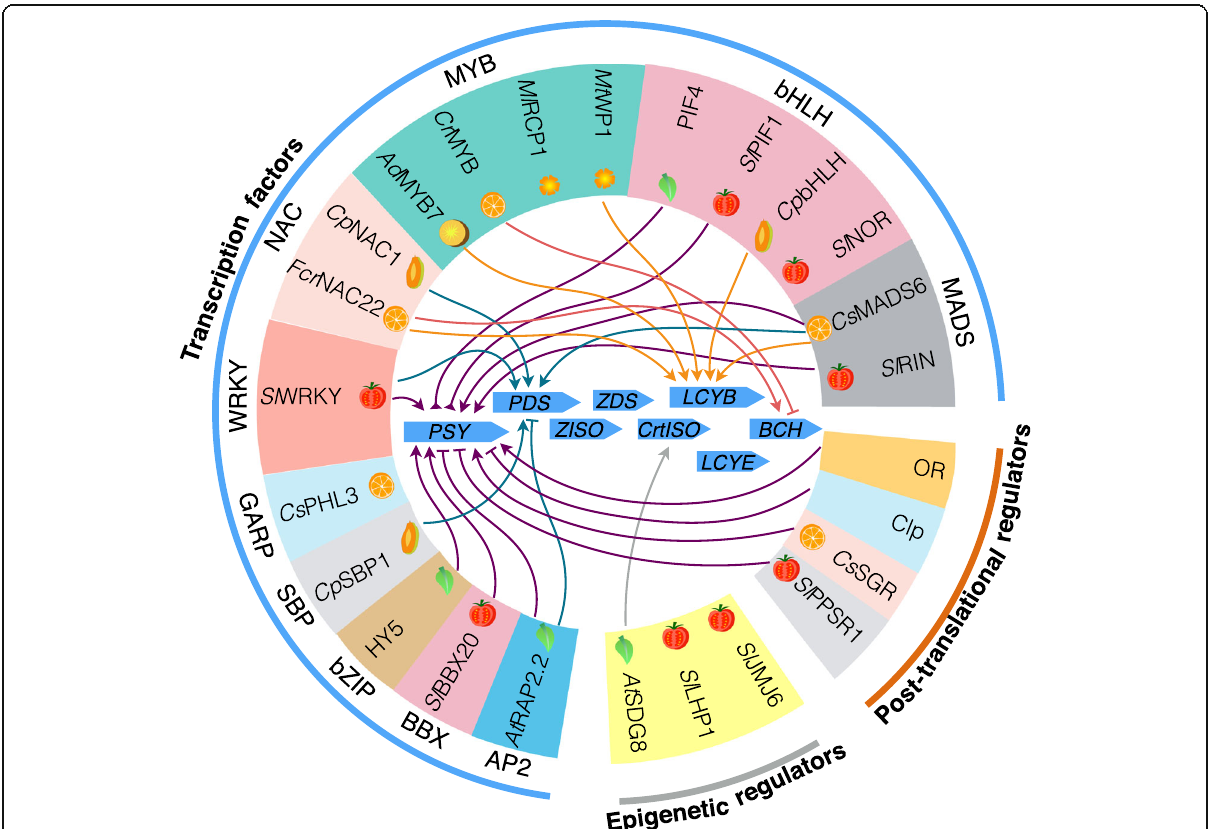
Fig. 3 Summary of some known transcription factors, post-translational regulators, and epigenetic regulators that regulate the expression of carotenogenic pathway genes or PSY protein. Their direct actions on pathway genes or PSY protein in different organs such as leaf, carotenoid- rich fruit, and flower are indicated. Those transcription factors are clustered by the family of transcription factors. MYB, Myeloblastosis family of transcription factors; RCP1, REDUCED CAROTENOID PIGMENTATION1; WP1, WHITE PETAL1; NAC, NAM, ATAF, and CUC transcription factors; WRKY, WRKYGQK motif-containing transcription factors; PHL3, PHOSPHATE STARVATION RESPONSE FACTOR LIKE3; SBP1, SQUAMOSA PROMOTER BINDING PROTEIN1; HY5, ELONGATED HYPOCOTYL5; BBX, B-box transcription factors; RAP2.2, APETALA2/ethylene response factor-type transcription factor 2.2; PIF, PHYTOCHROME-INTERACTING FACTORS; bHLH, basic Helix-Loop-Helix transcription factors; NOR, NON-RIPENING transcription factor; MADS, MADS-box containing transcription factors; RIN, RIPENING INHIBITOR; OR, ORANGE protein; Clp, Clp protease; SGR, STAY GREEN; PPSR1, Plastid Protein Sensing RING E3 ligase 1; JMJ6, Jumonji C-terminal (JmjC) domain-containing demethylase 6; LHP1,